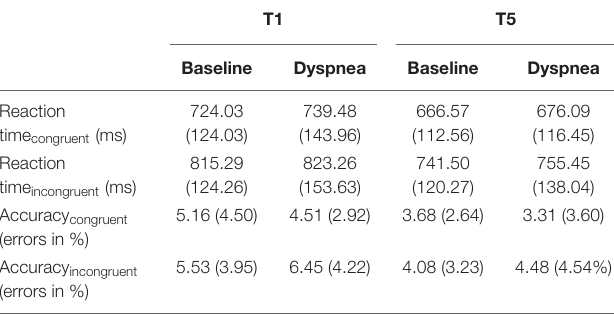
TABLE 4 | Means ( SD ) of behavioral measures for each condition for T1 and